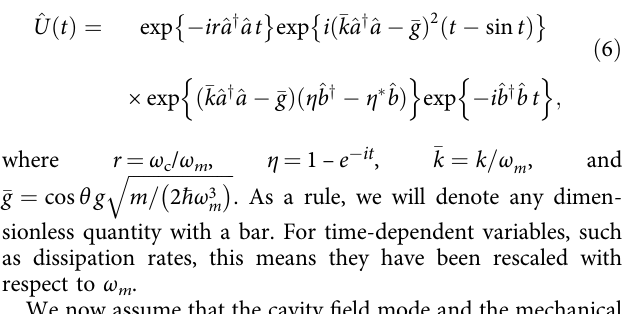
(cid:2) Fig. 2a with k ¼ (cid:2) g ¼ 1 and Fig. 2b with are plotted with α = β = 1. We observe that the system performs increasingly complex trajectories for larger values of (cid:2) g